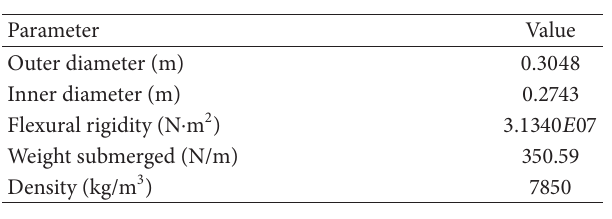
Table 1: Parameters of SCR.